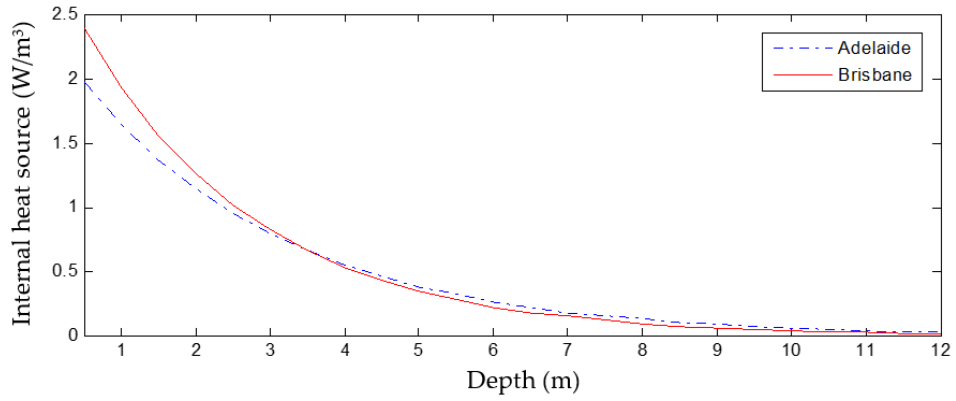
Figure 7. The absolute value of the internal heat source at various depths.